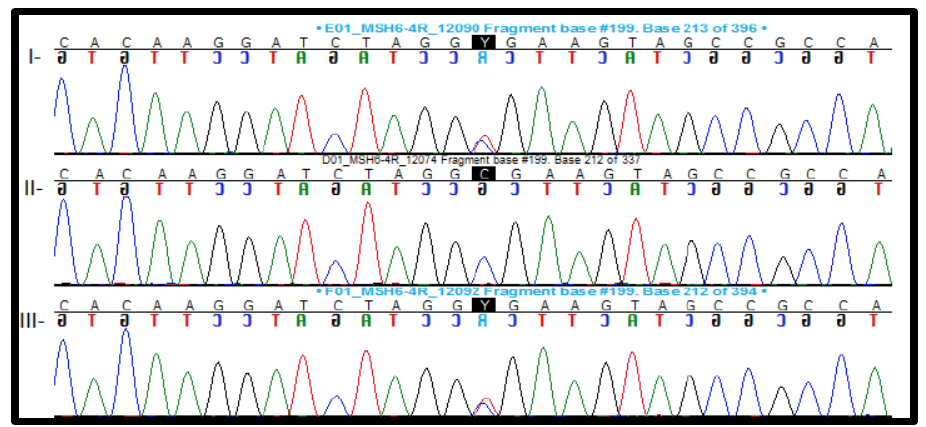
Figure 2. Figure of Sanger sequencing. I — Index case: patient #33 presenting a nonsense variant in the MSH6 gene (c.328C > T, p.Arg110*; rs63750019); II — mother of index case; and III — father of index